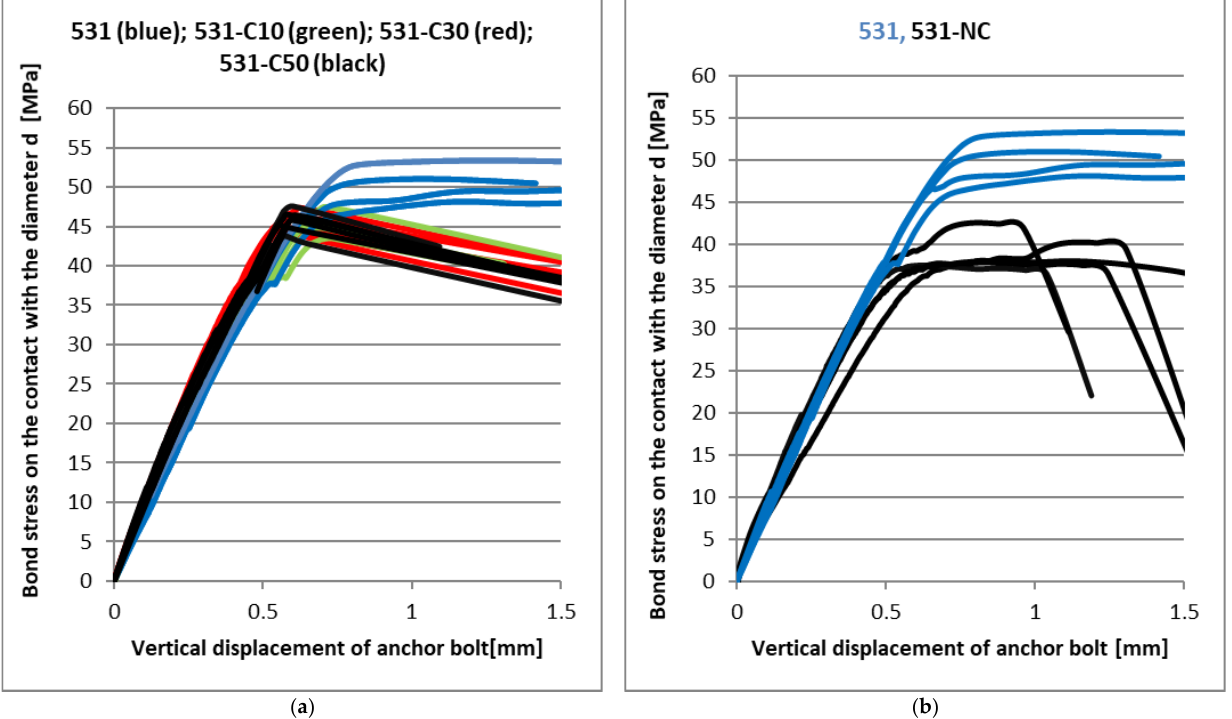
Figure 10. ( a ) CHS Epoxy 531 without carbon fibres; ( b ) CHS Epoxy 531 with nanotubes [9].